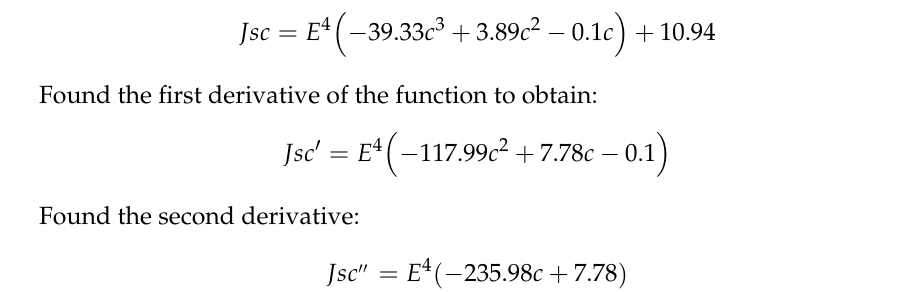
Figure 9. J-V characteristic curve of electrolyte solar cells with small gradient and different iodine concentrations.